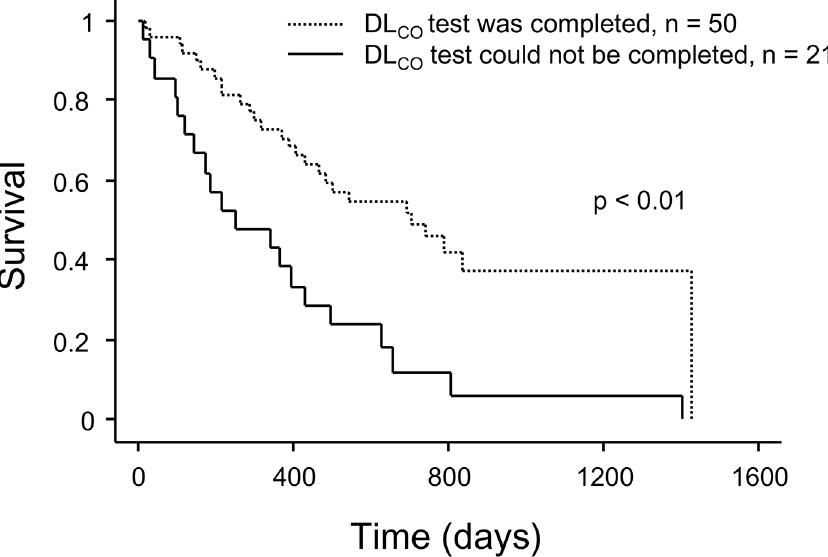
Fig 2. Kaplan − Meier survival curves for candidates with interstitial lung disease grouped based on the ability to perform the DL CO test. p < 0.01 by log-ranktest. DL CO , diffusing capacity of the lung for carbon